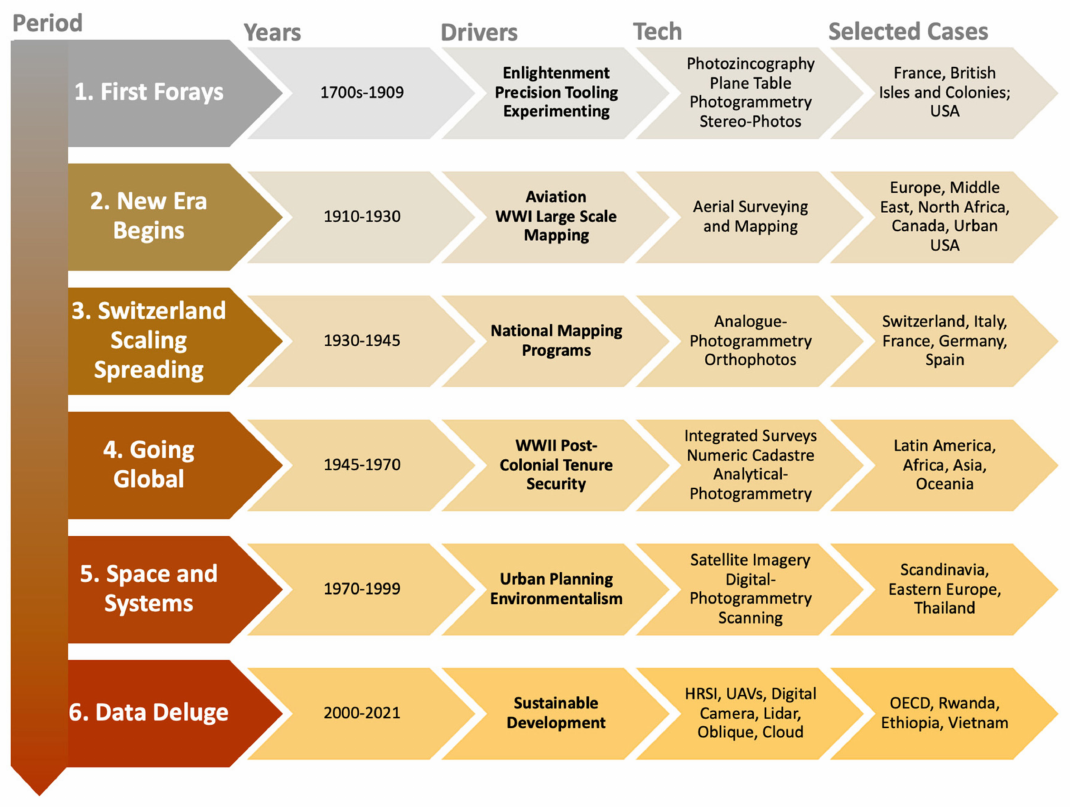
Figure 12. Origins and developments of photogrammetry and remote sensing applied in land